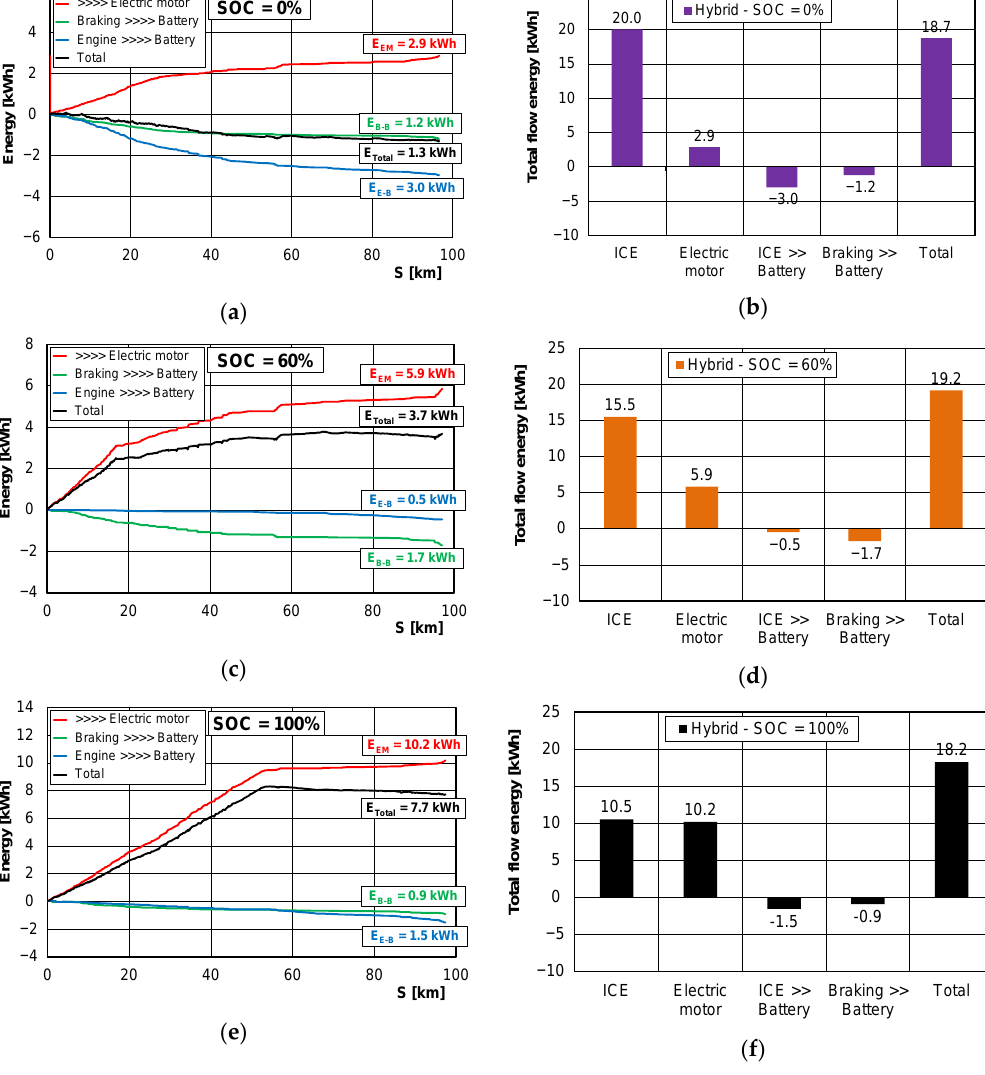
( b ) Figure 14. The energy flow for the electric vehicle for different states of charge ( a ) and the accumulated energy demand of the vehicles ( b ).